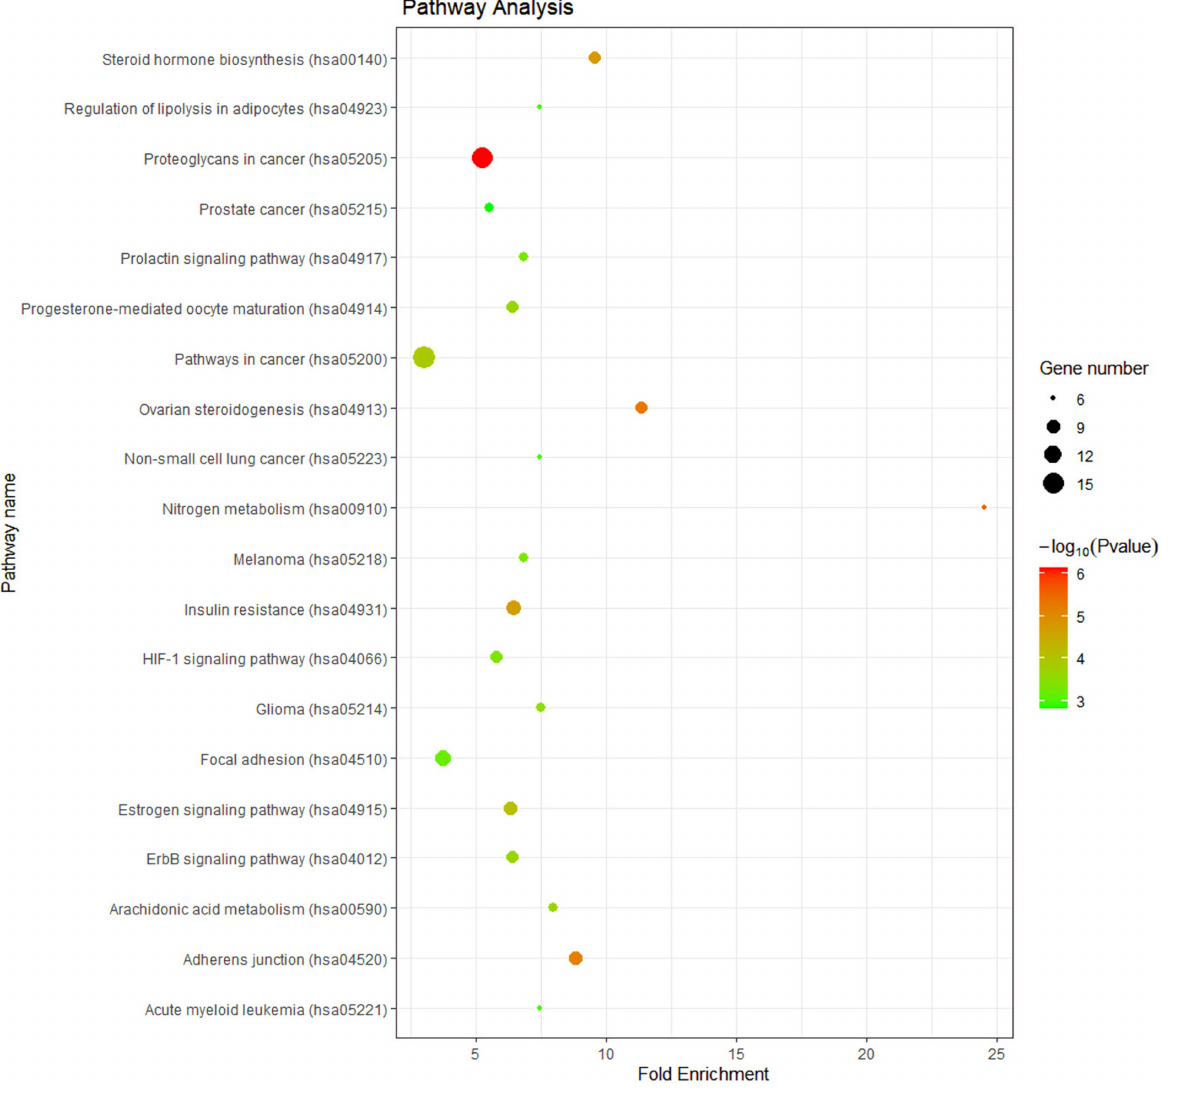
Figure 5. The KEGG pathway analysis of key